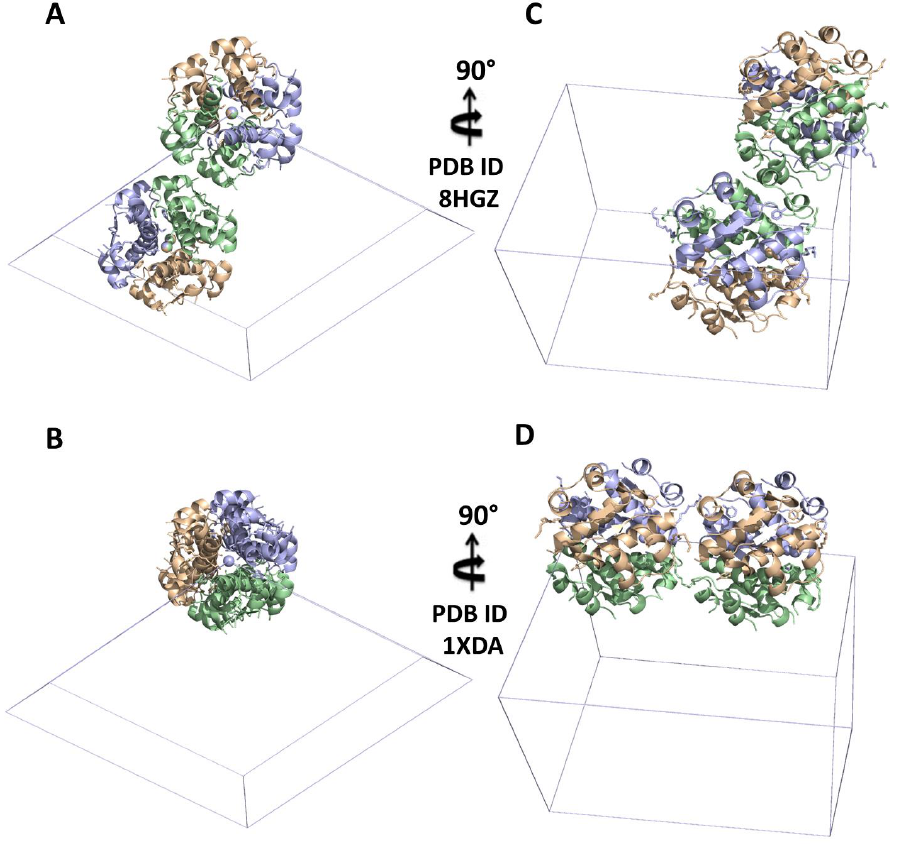
Figure 2. Comparison of the differences in unit cell origin of 8HGZ cryogenic structure and 1XDA cryogenic structure. ( A ) 8HGZ structure is presented in unit cell mode, also rotated 90 degrees ( C ). ( B ) 1XDA reference model is presented in unit cell mode, rotated 90 degrees ( D ), as well.